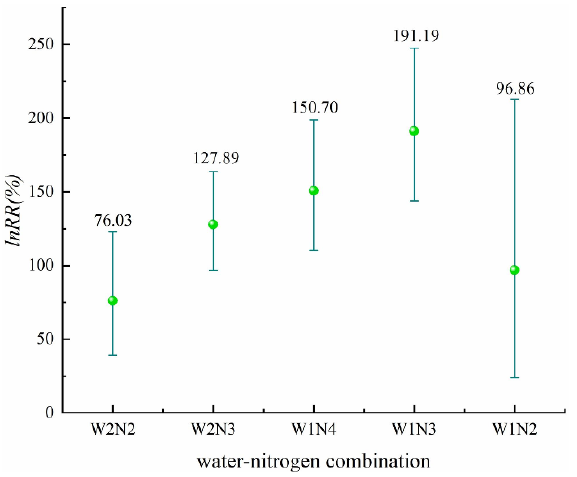
Figure 6. Effect of different water – nitrogen combinations on N 2 O emissions ( p = 0.00000).